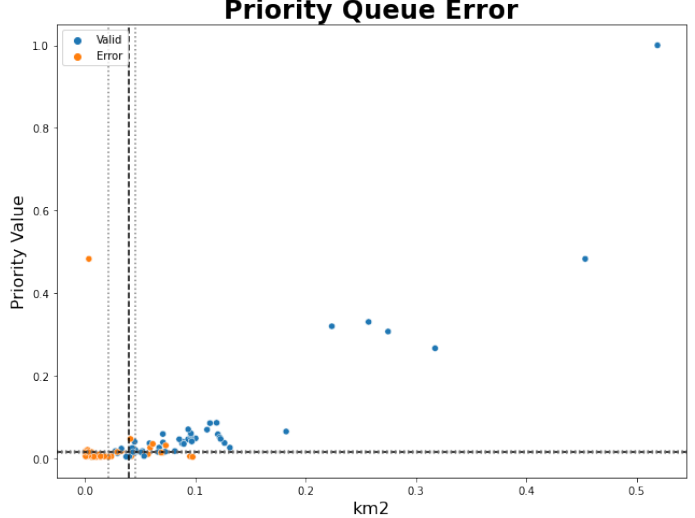
Figure 7. Median thresholds of the priority value and site area improved the overall accuracy of the priority queue.